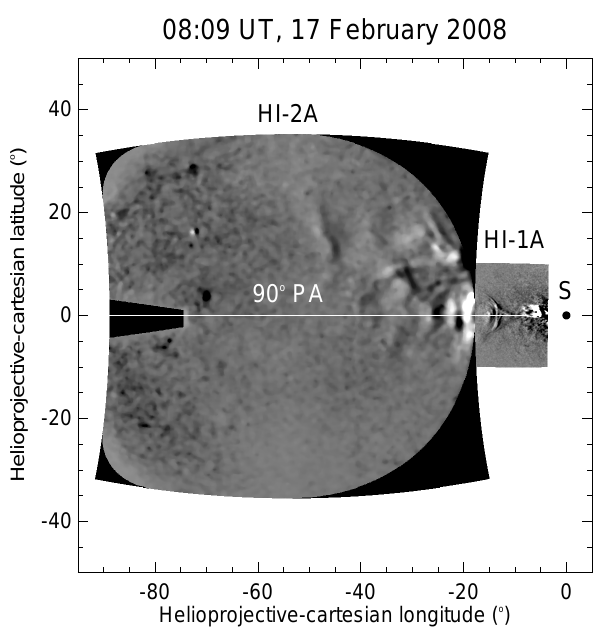
Fig. 2. A composite running difference image from the HI-1A and HI-2A cameras both taken at 08:09UT on 17 February 2008. The transit of the CME can be observed to be passing through both cam- eras. These images are shown in Helioprojective Cartesian coordi- nates (Thompson, 2006), with a line of constant PA=90 ◦ . S marks the location of the